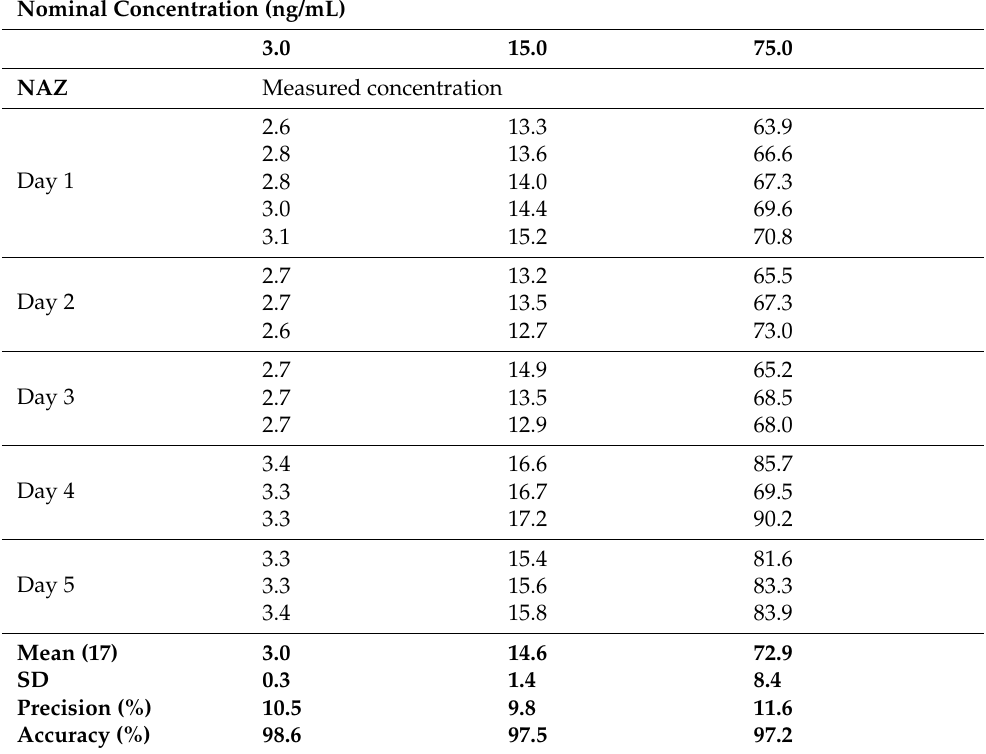
Table 4. Interday precision and accuracy for NAZ in plasma.